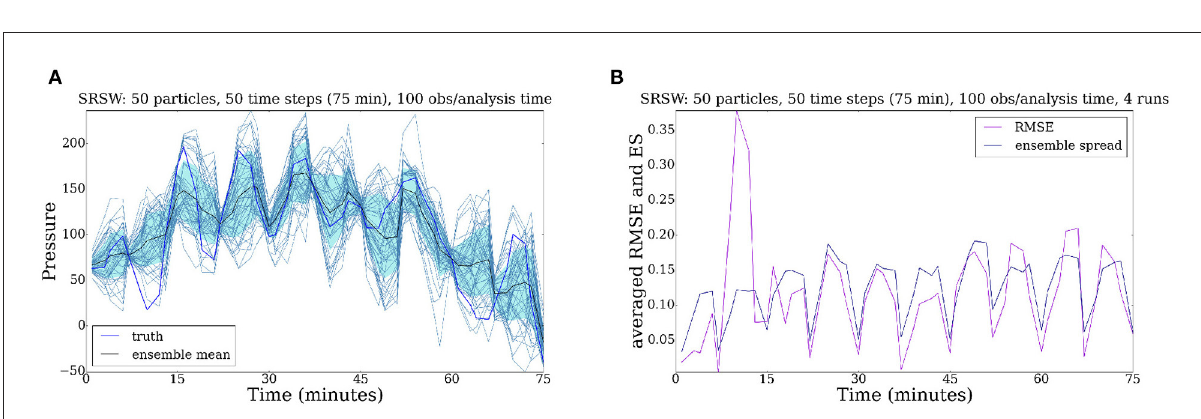
FIGURE11 Evolution of the SRSW model for 50 time steps. The system is observed every 5 time steps, with 100 observations/analysis time. A large number of observations improves the performance of the particle filter. (A) Pressure field. (B) RMSE.